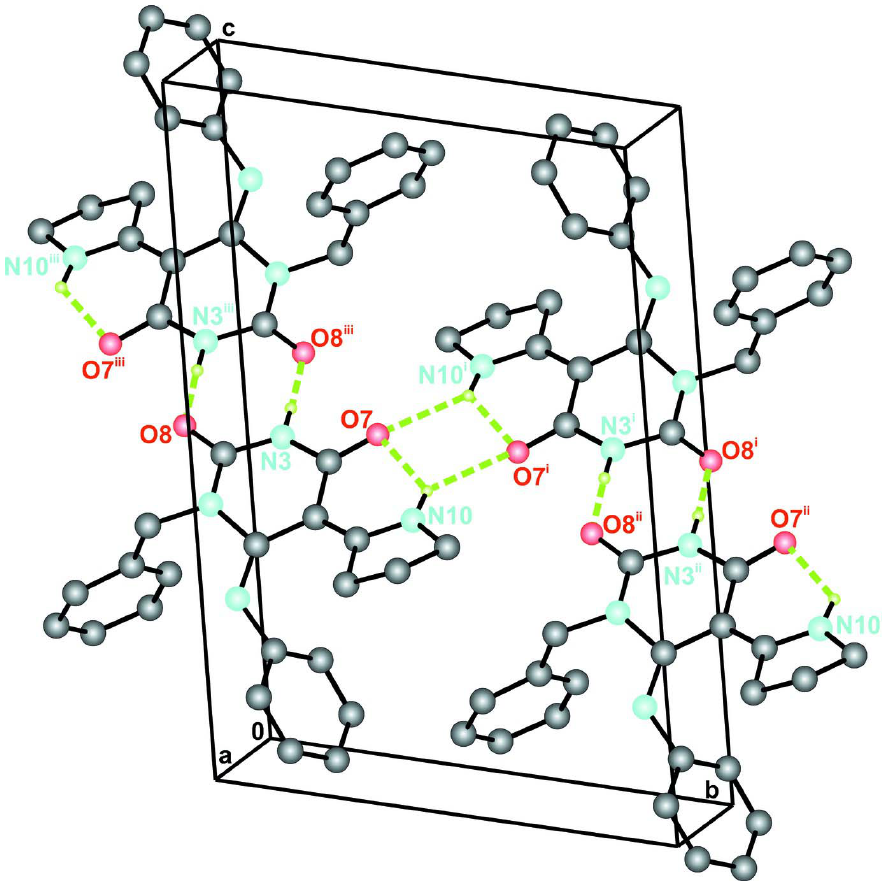
Unit cell packing of (I) showing infinite chains of molecules via hydrogen bonding; for clarifity only H atoms participating in bonding have been included. Symmetry cods: (i) 1 - x , 1 - y , 1 - z ; (ii) 1 + x , 1 + y , z ; (iii) - x , - y , 1 - z